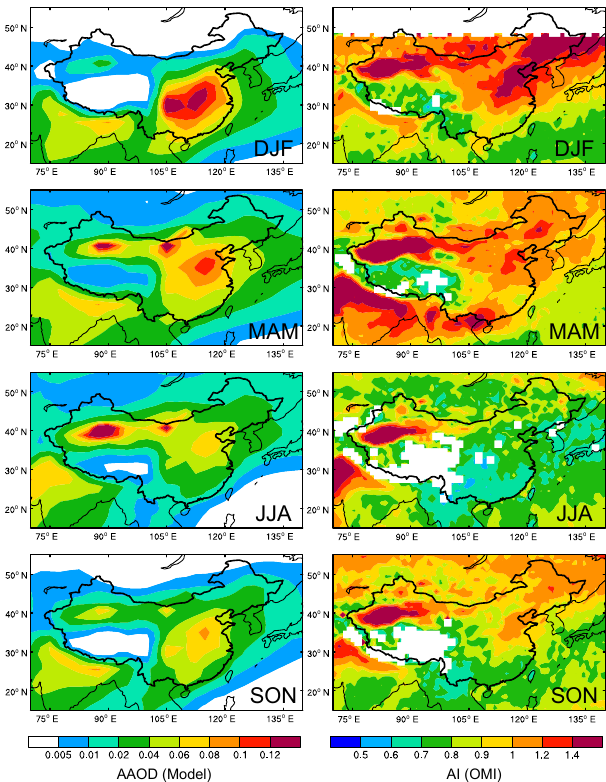
Figure 4. Spatial distribution of seasonal mean AAOD of total aerosols (left) and aerosol index (AI) derived from Ozone Moni- toring Instrument (OMI) measurements over 2010–2014 (right).